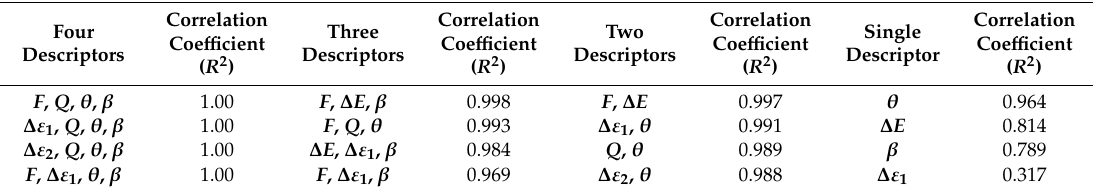
Table 6. Selected correlation coe ffi cient ( R 2 ) values for Ni2 complexes system by using the combinations of four, three, two and single descriptors.